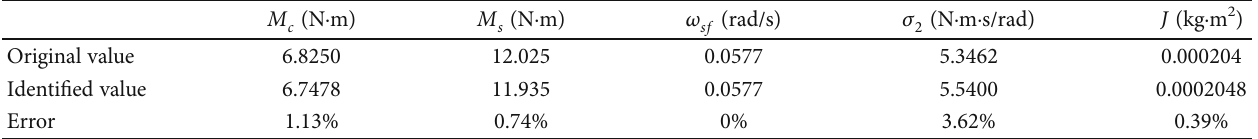
Table 1: Original values and identi fi ed values of the system load